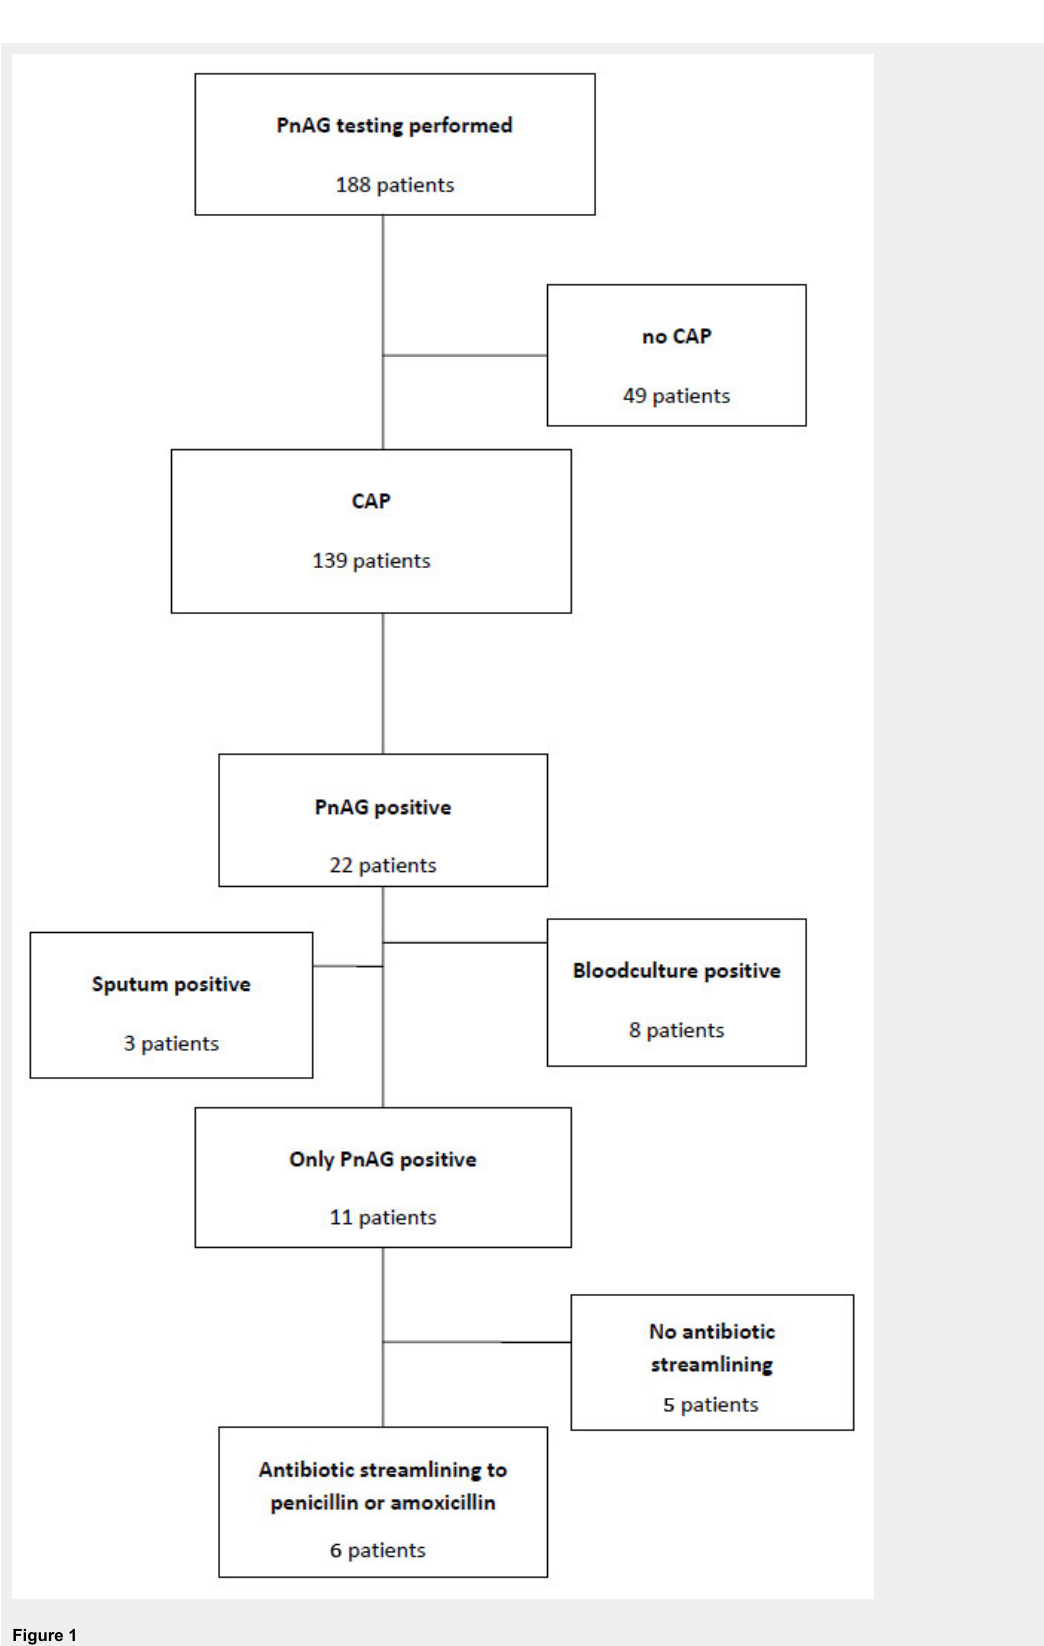
Figure 1 Patients in whom PnAG Test was performed. PnAG = Binax Now ® urine Pneumococcal Antigen